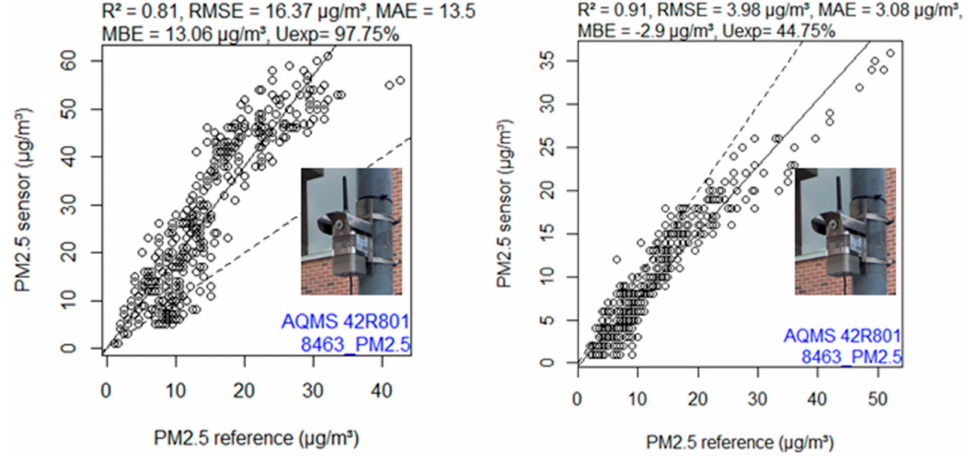
Figure 6. Regression plots of Airly PM 2.5 raw sensor readings against reference data during a winter (1; left) and summer (2; right) co-location campaign. Associated performance metrics (R 2 , RMSE, MAE, MBE and U exp ) are provided above the